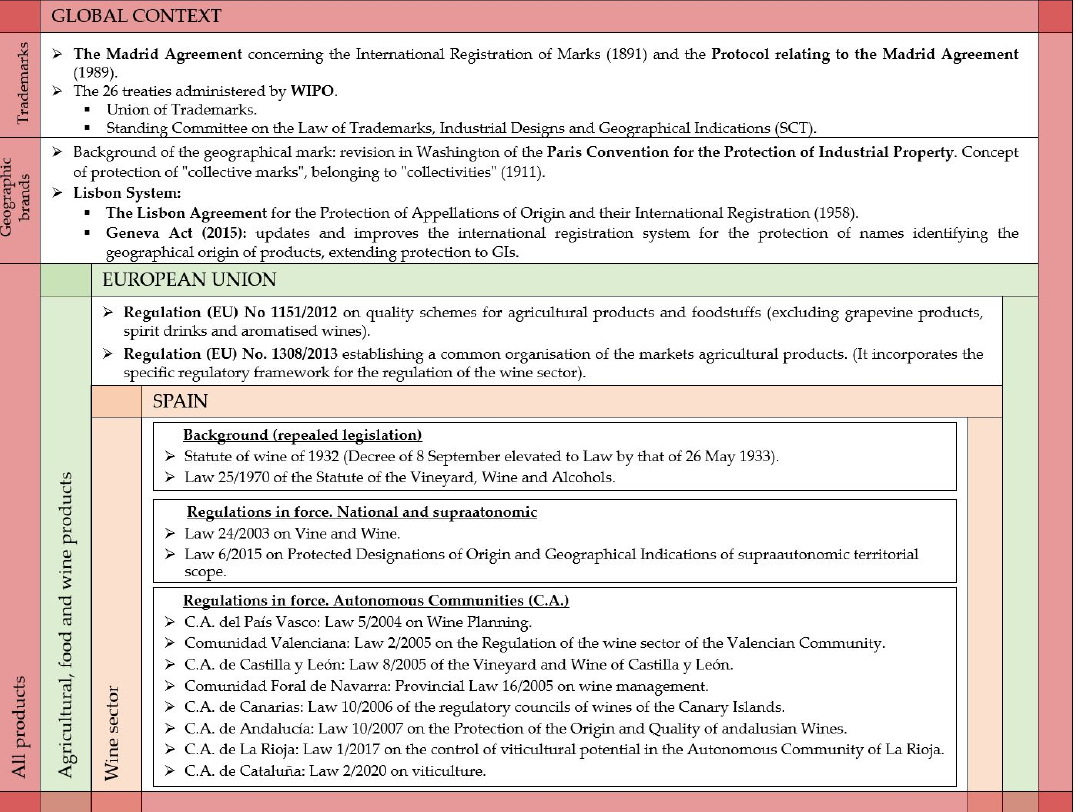
Figure 2. Global and European regulatory framework for the geographical quality marks, focused on the wine sector for Spain. Source: Own elaboration.